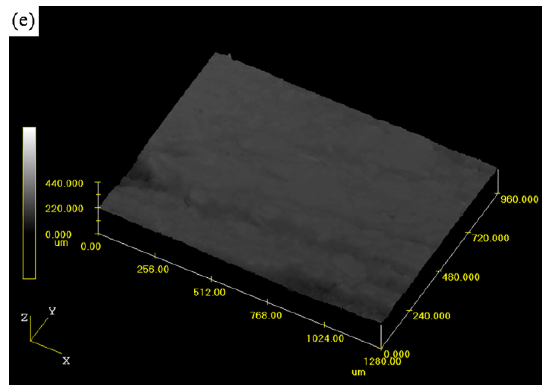
Figure 8. Three-dimensional reconstructions of surface geometry of ( a ) FC-0; ( b ) FC-2; ( c ) FC-4; ( d ) FC-6; ( e ) FC-8. Table 3. Surface roughness parameters of the friction composites.